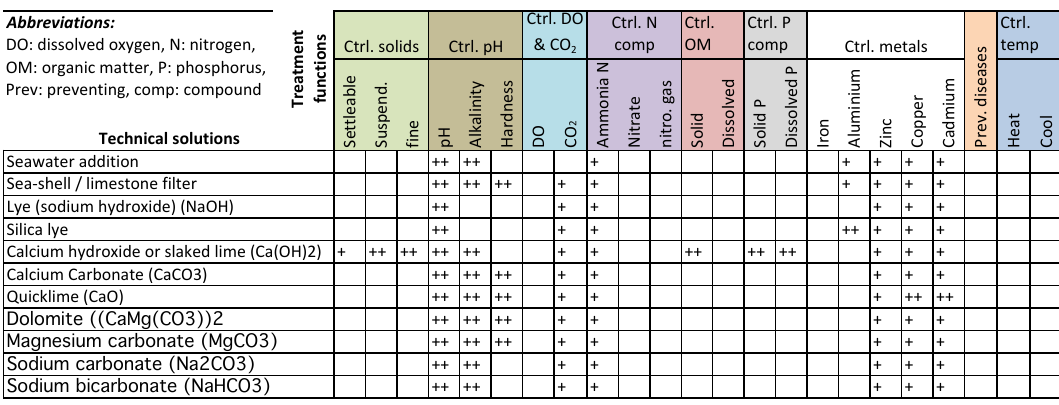
Table 3. QFD matrix presenting how pH control methods influence different treatment functions.